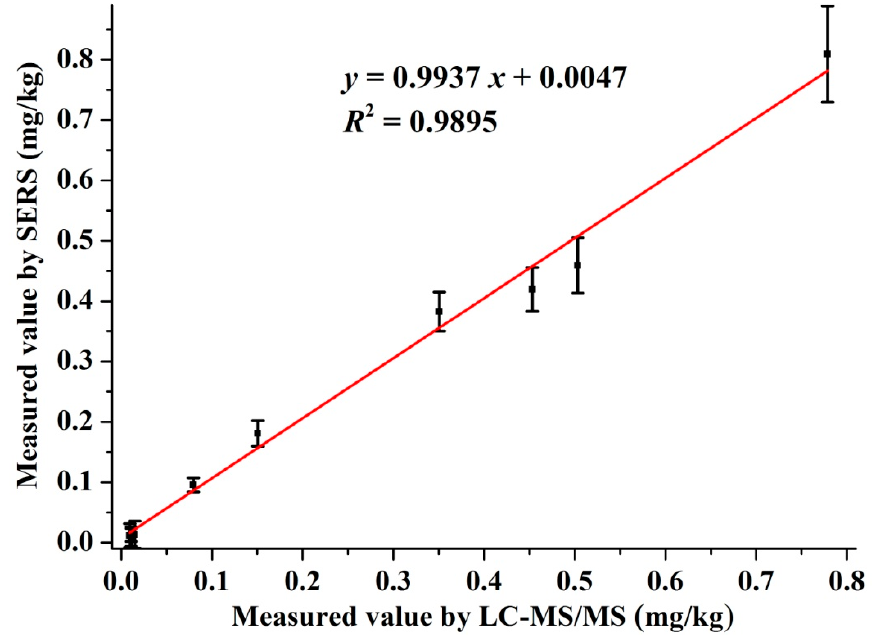
Figure 5. Correlation between SERS and LC-MS/MS for detection of pymetrozine in cabbage samples.